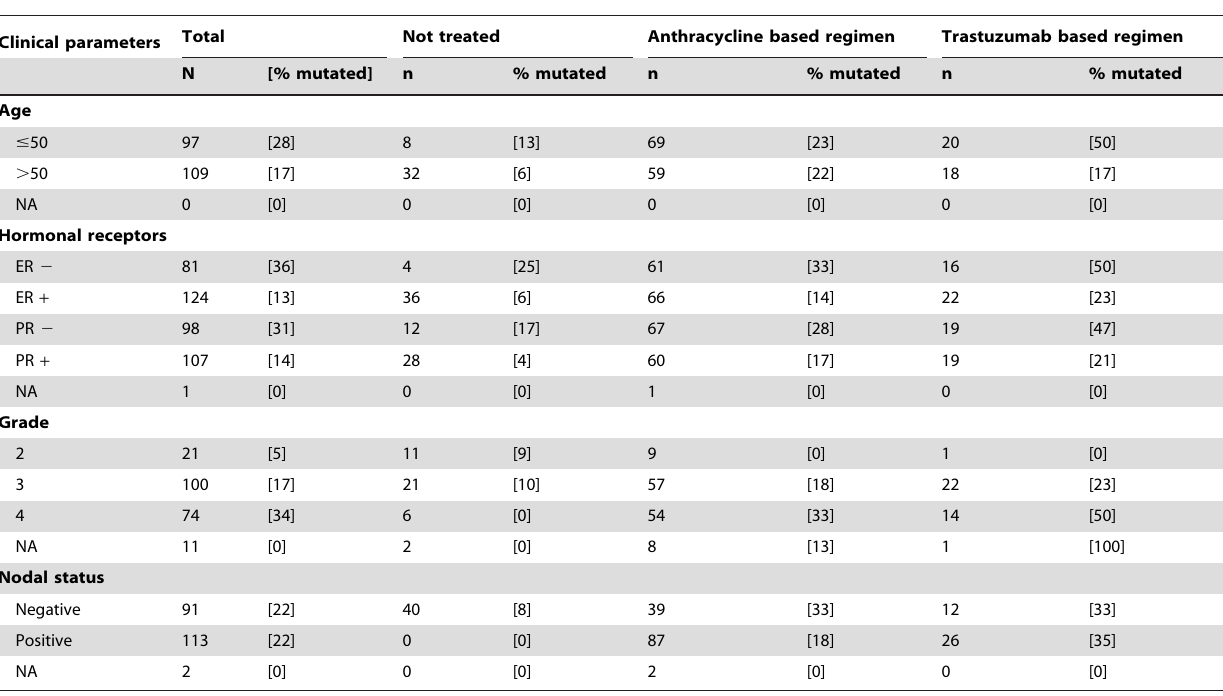
Table 1. Clinical details of studied